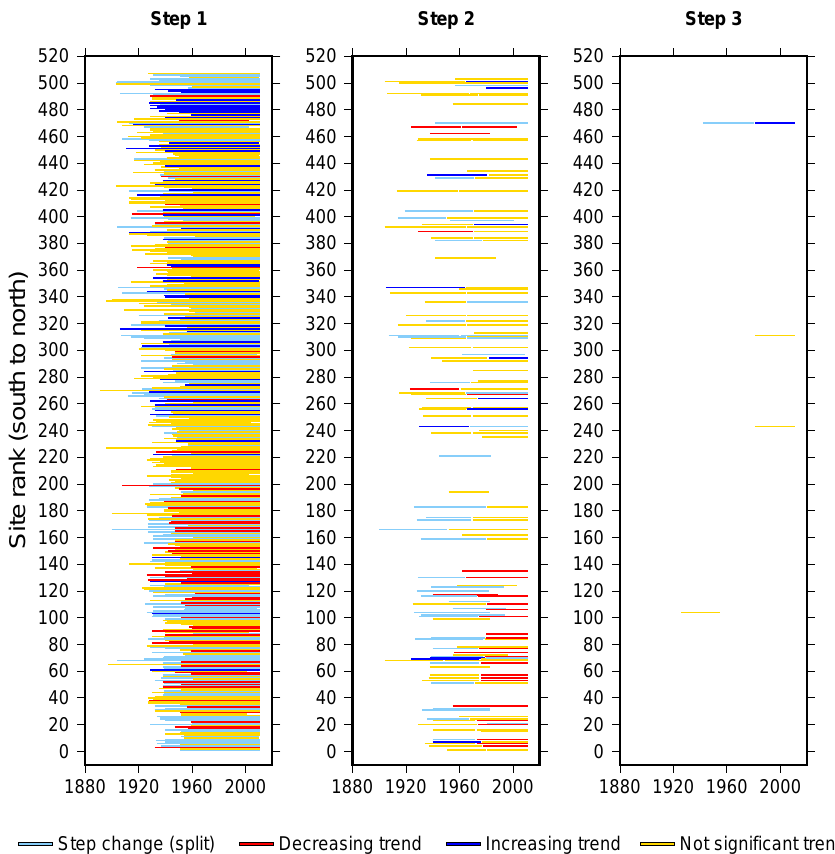
Figure 3. Range of years for each site that contain a step change, show a trend, or are stationary, for each step of the decomposition algorithm.